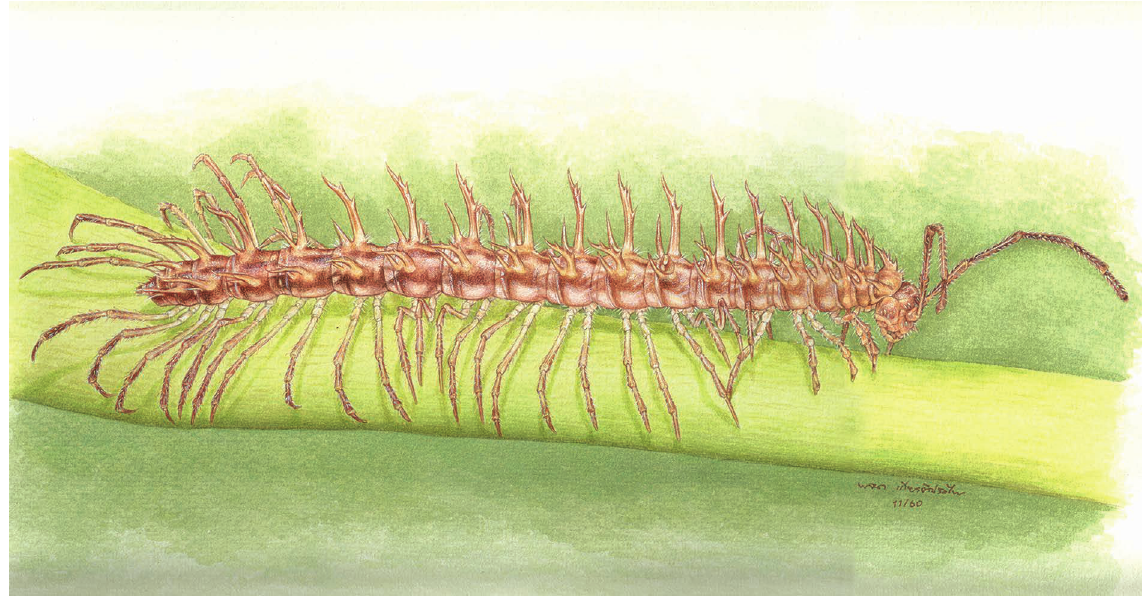
Fig. 1. Gigaxytes fusca Srisonchai, Enghoff & Panha gen. et sp. nov., ♂ paratype. Watercolour by Photchana